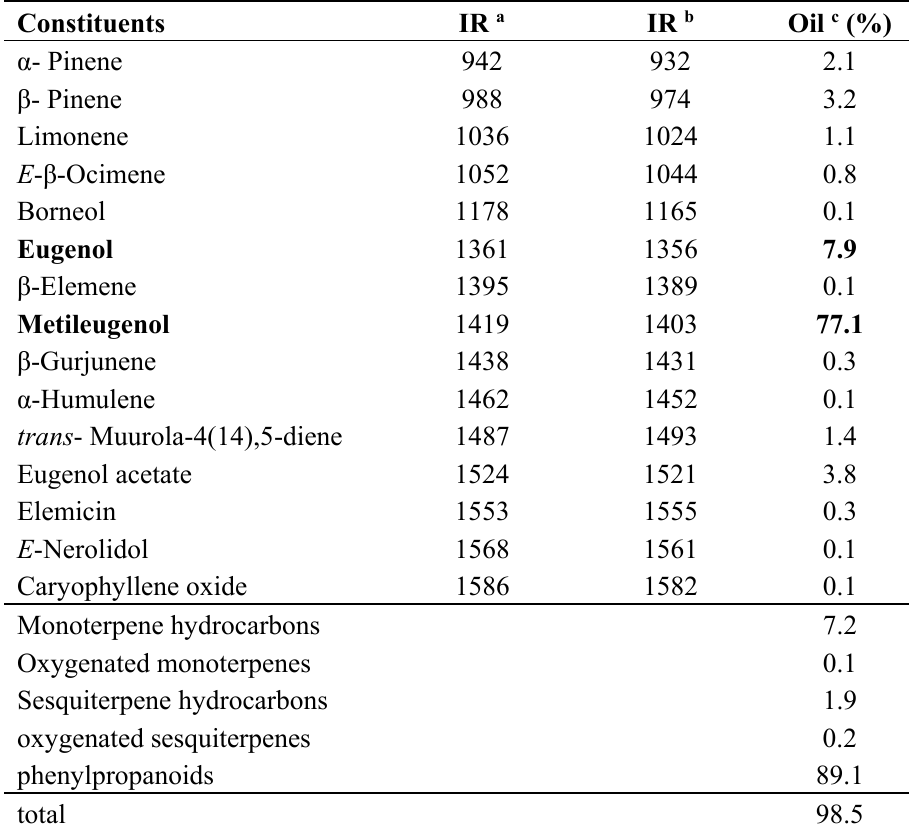
Table 1. Oil composition (%) of P. divaricatum .